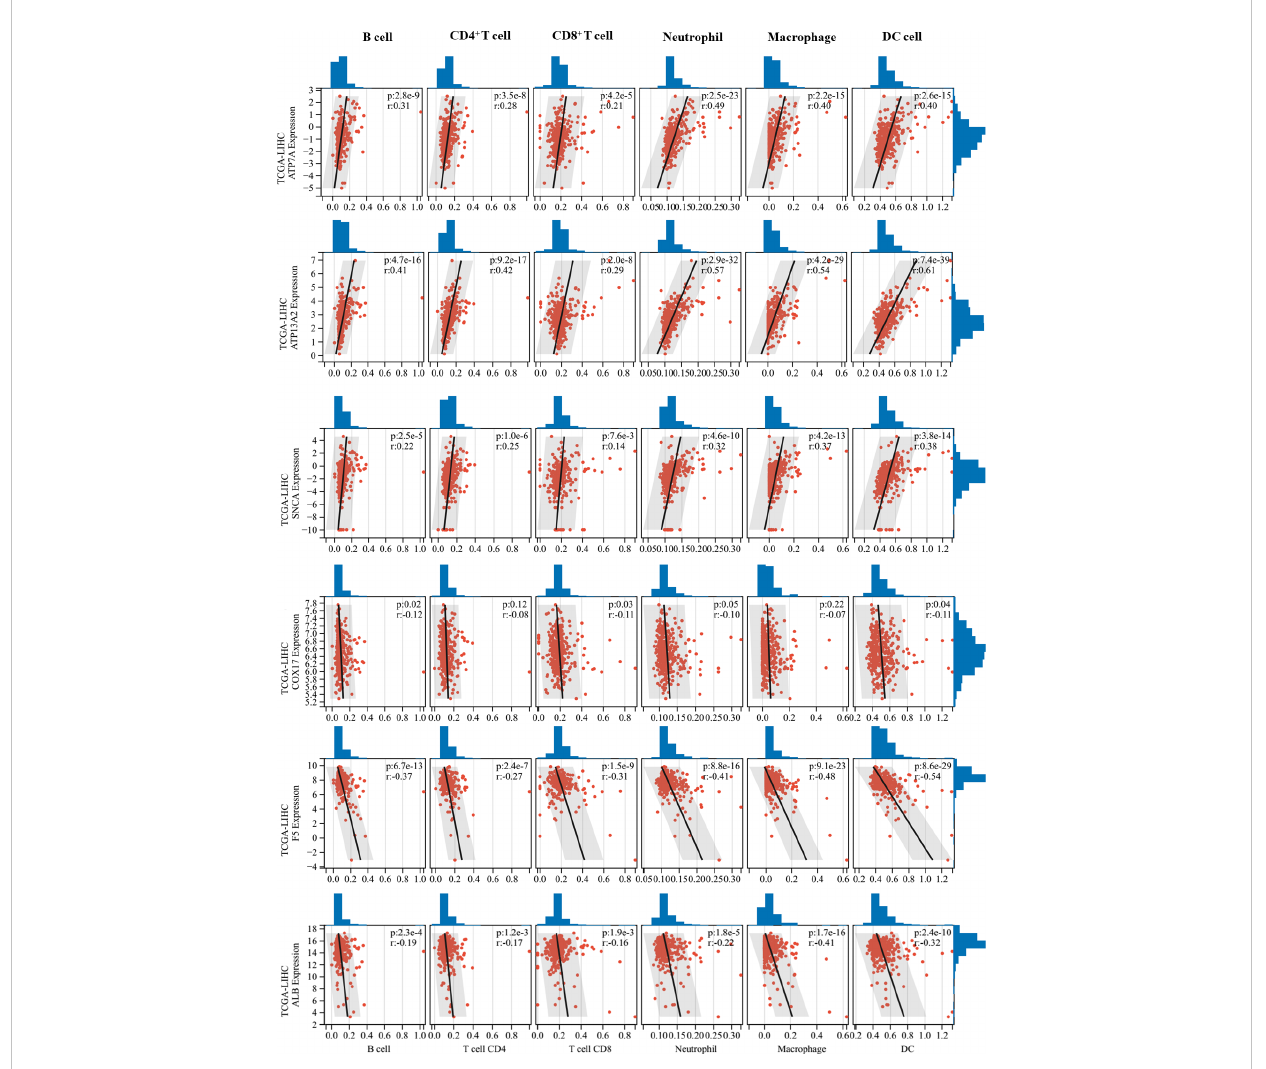
FIGURE 5 Correlations between critical cuproptosis-related genes (CRGs) and tumor immune cell in fi ltration. ATP7A, ATP13A2, and SNCA were positively correlated with multiple types of immune cell in fi ltration in hepatocellular carcinoma (HCC), while COX17, F5, and ALB were negatively correlated with immune cell in fi ltration in